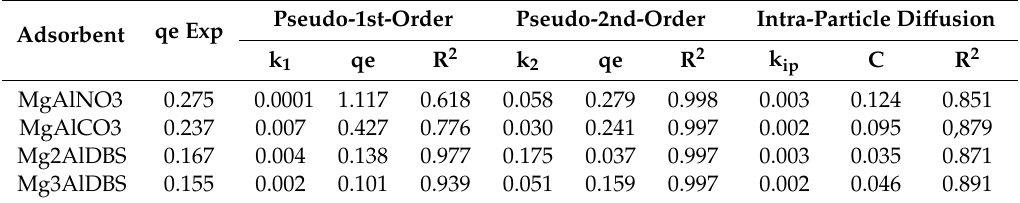
Table 3. Kinetic parameters of pseudo-first-order, pseudo-second-order and intra-particle di ff usion models for DGB adsorption by MgAlNO3, MgAlCO3, Mg2AlDBS and Mg3AlDBS.